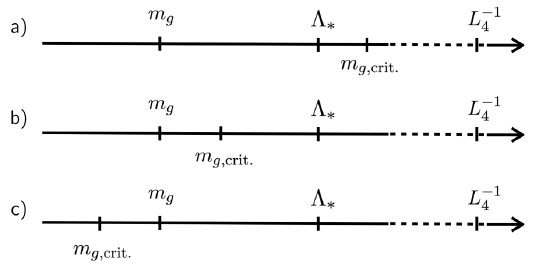
Figure 5 . For the range m g crit. < m g < Λ ∗ , shown in case c), the island contributes to the entropy while the theory has a valid EFT